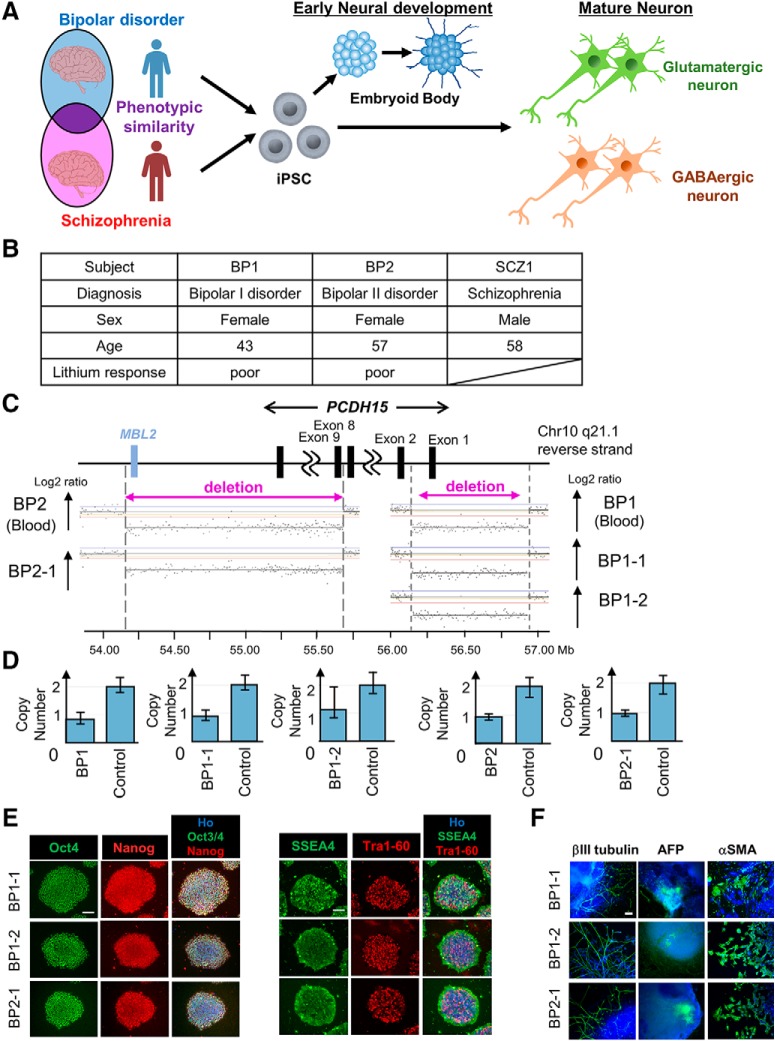
Generation and characterization of iPSCs derived from a BP patient. A, Schematic diagram of the strategy to explore the phenotypes of BP and SCZ in vitro. B, Subjects list containing basic information. C, CNVs in chromosome 10 were detected in blood and iPSCs derived from two BP patients by aCGH. D, The exonic deletions of PCDH15 identified in this study were validated by the TaqMan copy number assays. Bars indicate copy numbers predicted by the TaqMan copy number assays. Capped bars indicated the minimum and maximum copy number calculated for the sample replicate group (n = 4). Controls carried no aCGH-detected CNVs of PCDH15 (copy number = 2) and were used to calibrate the assays. E, The generated iPSCs expressed the pluripotent markers Oct4, Nanog, SSEA4, and Tra1-60. Scale bar, 100 μm. F, Representative images of immunocytochemical analysis for in vitro three-germ layer differentiation. βIII-Tubulin, αSMA, and AFP are pluripotent markers of the ectoderm, mesoderm, and endoderm, respectively. Blue indicates Ho, and green indicates the pluripotent marker. Scale bar, 100 μm.